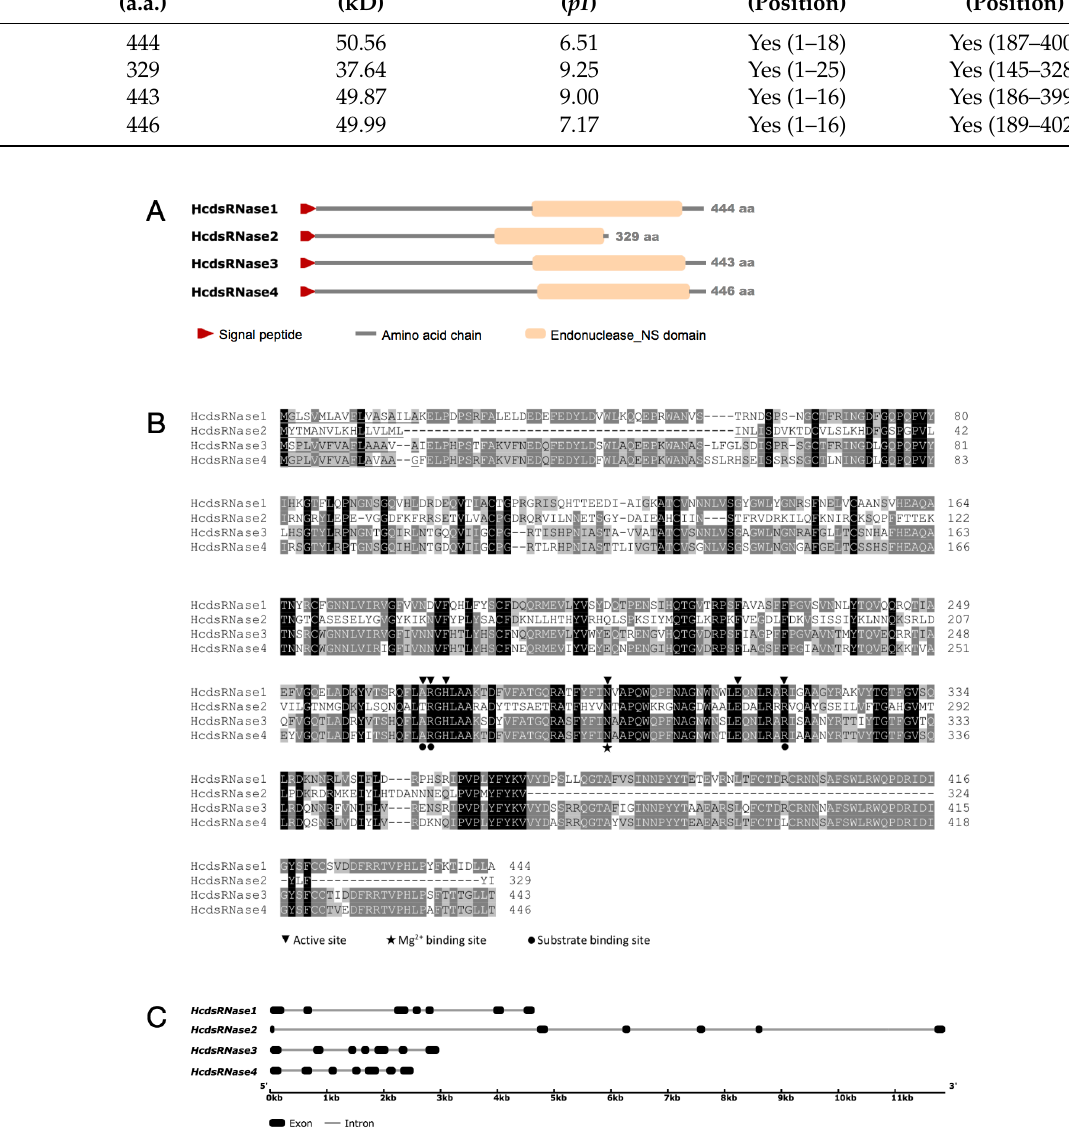
Figure 2. Deduced amino acid sequences analysis and gene structure analysis of HcdsRNases. ( A ) Domain arrangement in the aligned amino acid sequences of HcdsRNases. Red arrows indicate the location of signal peptides, orange boxes represent endonuclease NS domains, and gray lines represent amino acid chains. ( B ) Multiple sequence alignment of deduced HcdsRNase proteins. Residues highlighted in black and gray are conserved and similar, respectively. Signal peptides are underlined. Active sites are marked by triangles, the Mg 2+ binding site by a star, and substrate binding sites by circles. ( C ) Gene structures of the HcdsRNases. Squares and lines indicate exons and introns, respectively, in individual HcdsRNase genes.